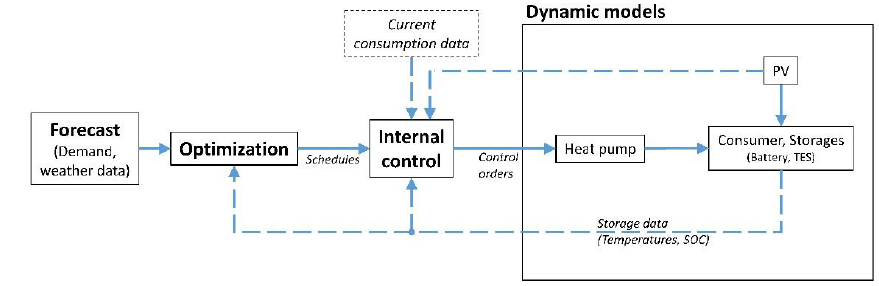
Figure 2. Schematic flowchart of the simulation model.